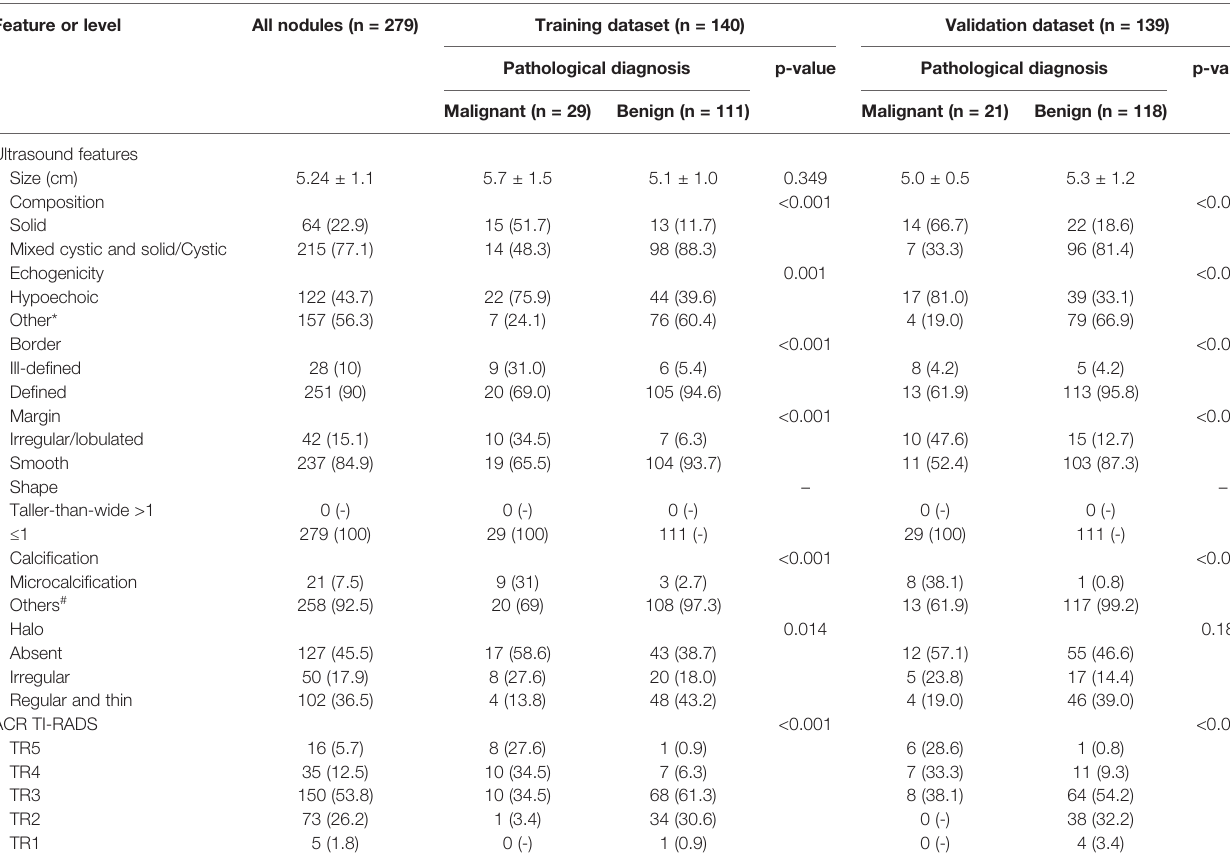
TABLE 2 | Ultrasound features and ACR TI-RADS levels for 279 thyroid nodules > 4 cm.